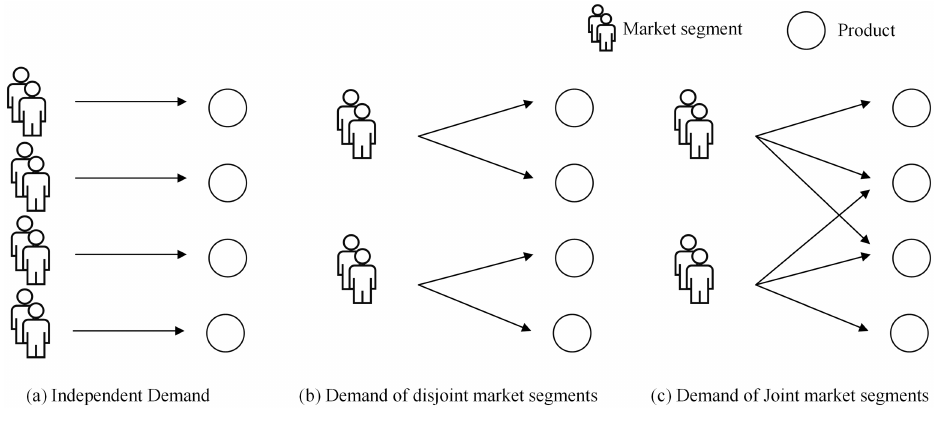
Fig 2. Three patterns of demand in airline seat inventory